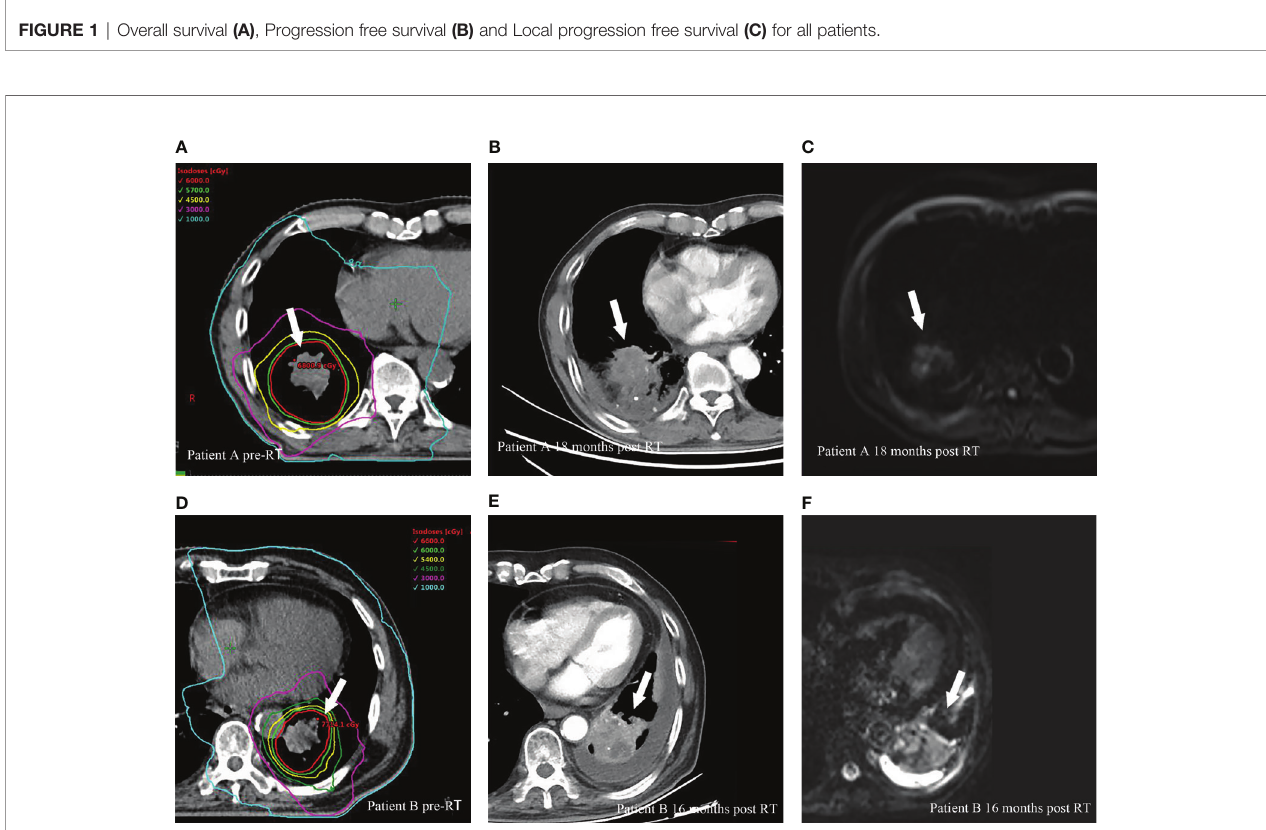
FIGURE 2 | Representative cases of local recurrences within SIB region for two patients after HypoRT treatment. Planning computed tomography fused with isodose levels before RT courses for patient A (A) , diagnostic computed tomography (B) and magnetic resonance diffusion weighted imaging (C) showed a local recurrence (arrows) 18 months after RT. (D – F) presented the planning imaging, the local recurrence in diagnostic computed tomography and magnetic resonance diffusion weighted imaging 16 months after RT for patient